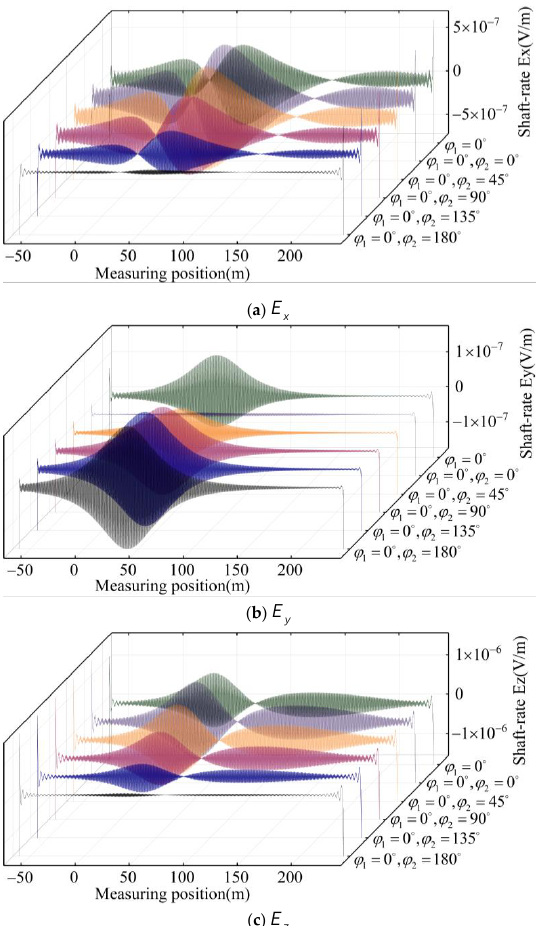
Figure 11. Distribution of XYZ components of a ship ’s shaft-rate electric field.